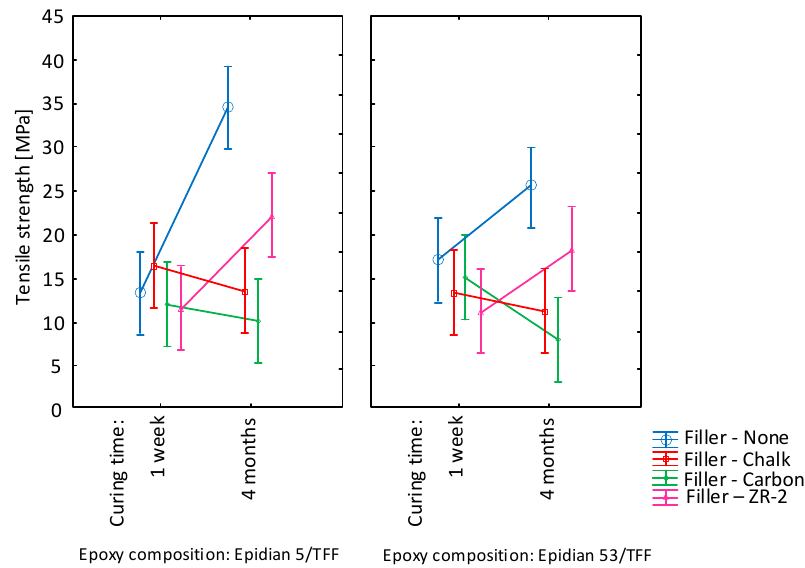
Figure 13. Graphs of interactions on the tested epoxide compositions including the qualitative factors: curing time and filler (vertical bars represent confidence intervals 0.95).